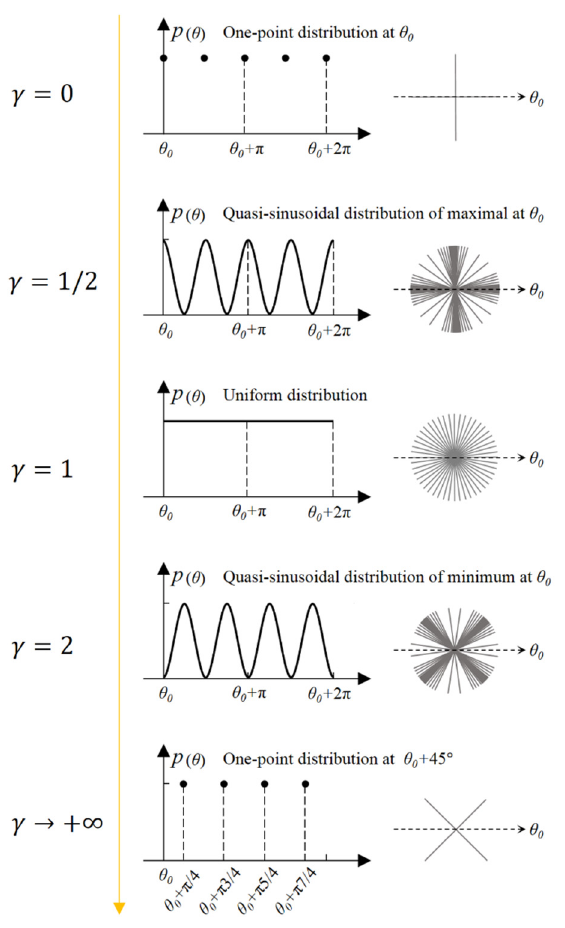
Figure 2. The physical meaning of aggregation parameter γ with different numerical values.